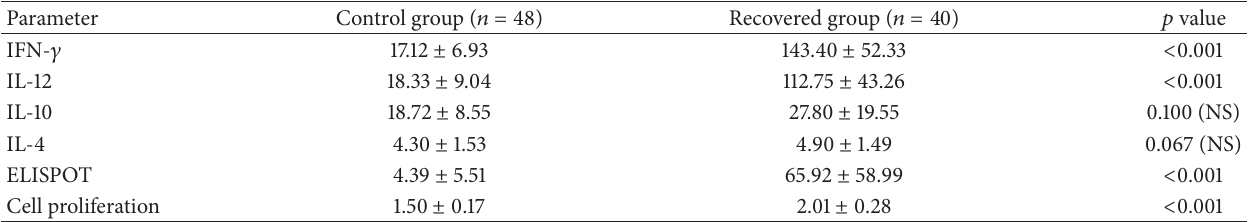
Table 1: Results of cytokine, lymphocyte proliferation, and ELISPOT assays in response to truncated ORF2 protein in HEV recovered individuals and control